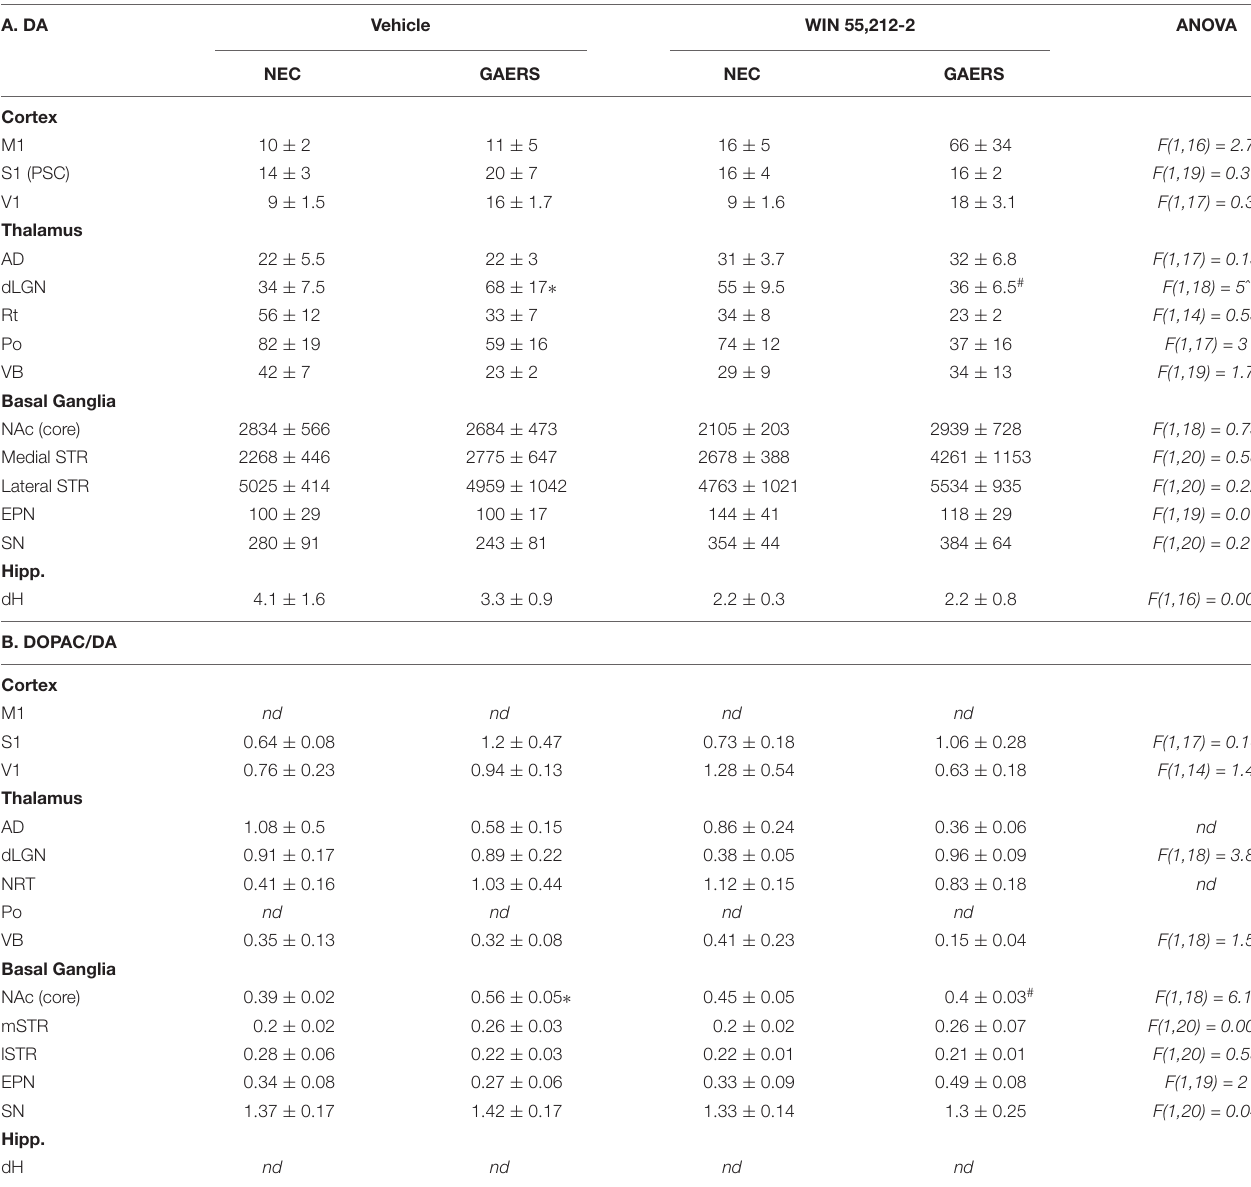
TABLE 2 | Effect of WIN 55,212-2 and its vehicle on Dopamine (DA) tissue content and the ratio DOPAC/DA in selected brain regions of GAERS and NEC rats. A.